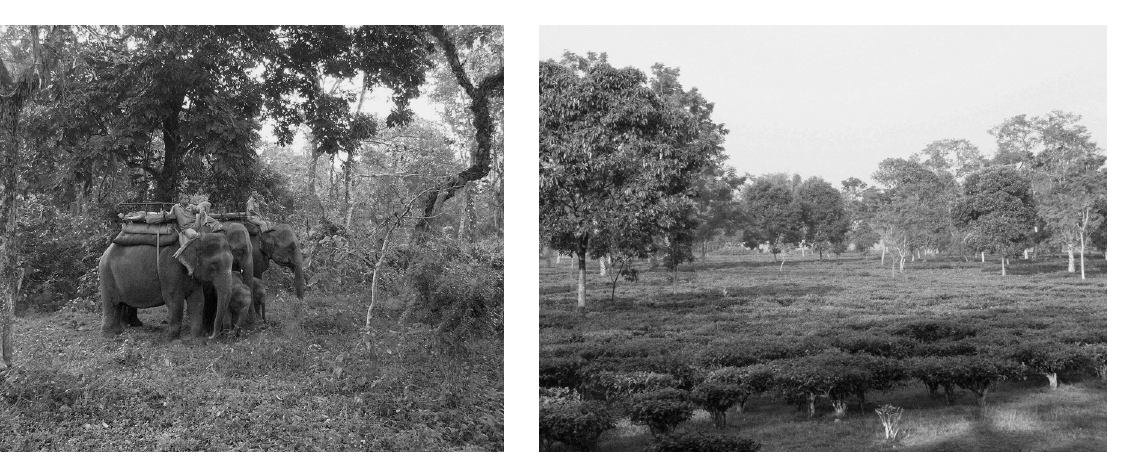
Fig. 2b. Tea plantation at the high terrace near Rehti river.